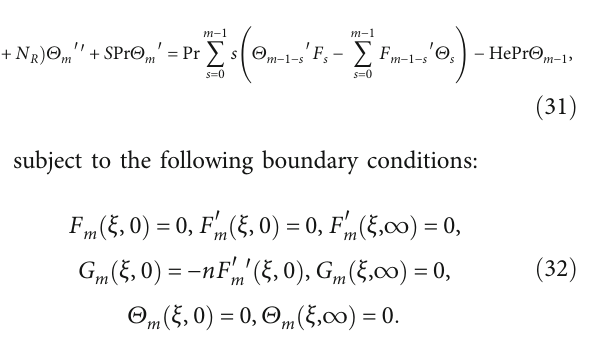
R = 0 : 6, Ω = 0 : 6, andHe = 0 : 2